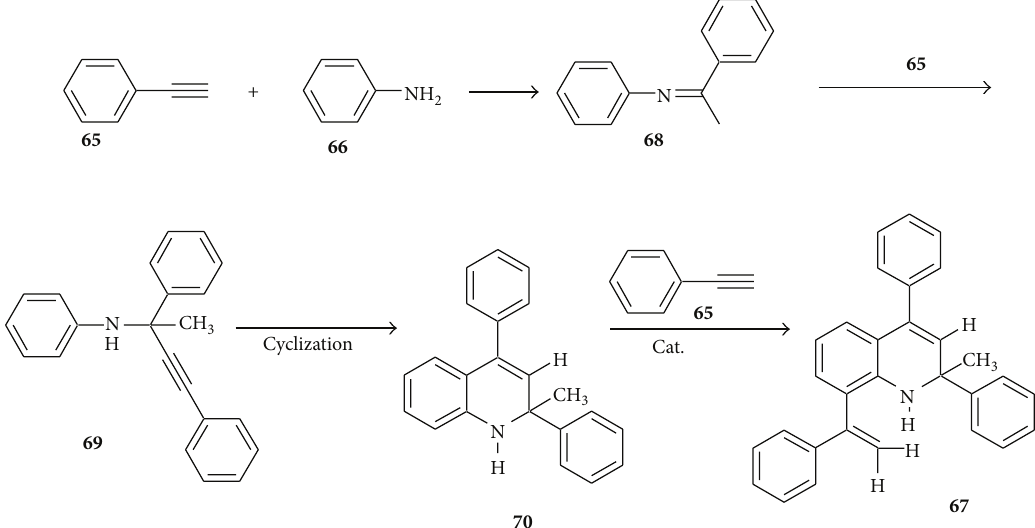
Scheme 12: Proposed mechanism for the synthesis of 67 .